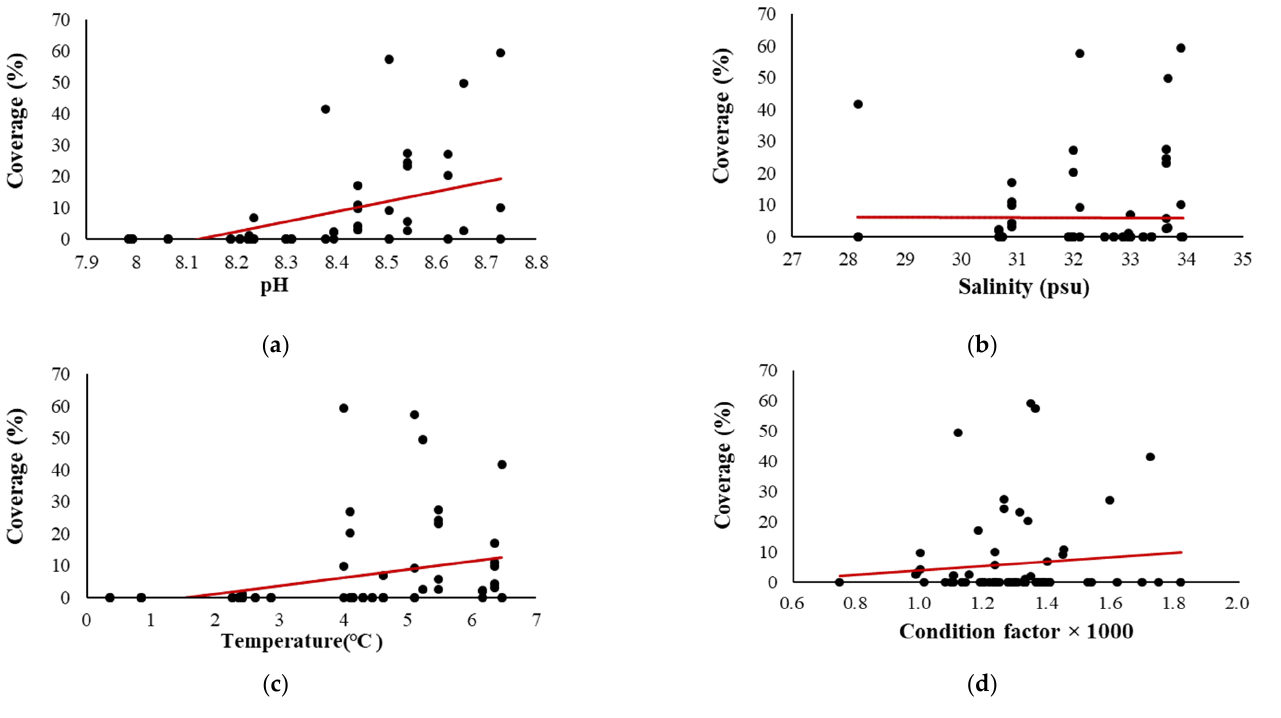
Figure 4. Relationship between ( a ) pH, ( b ) temperature, ( c ) salinity, and ( d ) CF and the coverage of coralline algae on the limpet shell. The red line indicates the trend line.